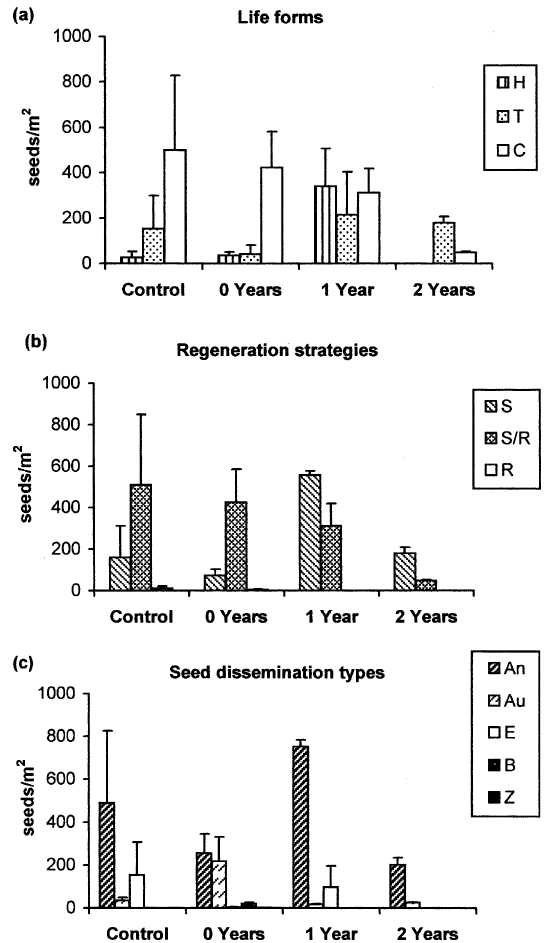
Fig. 1. Mean number of seeds per m 2 and SE of traits of species present in the soil seed bank in the control situation and in time after fire (0, 1, 2 yr). Life forms (a): H = Hemicryptophyte, T = Therophyte, C = Chamaephyte. Regeneration strategies (b): S = Seeders, R = Resprout, S/R = Seeders and resprouters. Seed dis- persion types (c): An = Anemochory, Au = Autochory, E = Epiz- oochory, B = Barochory and Z =